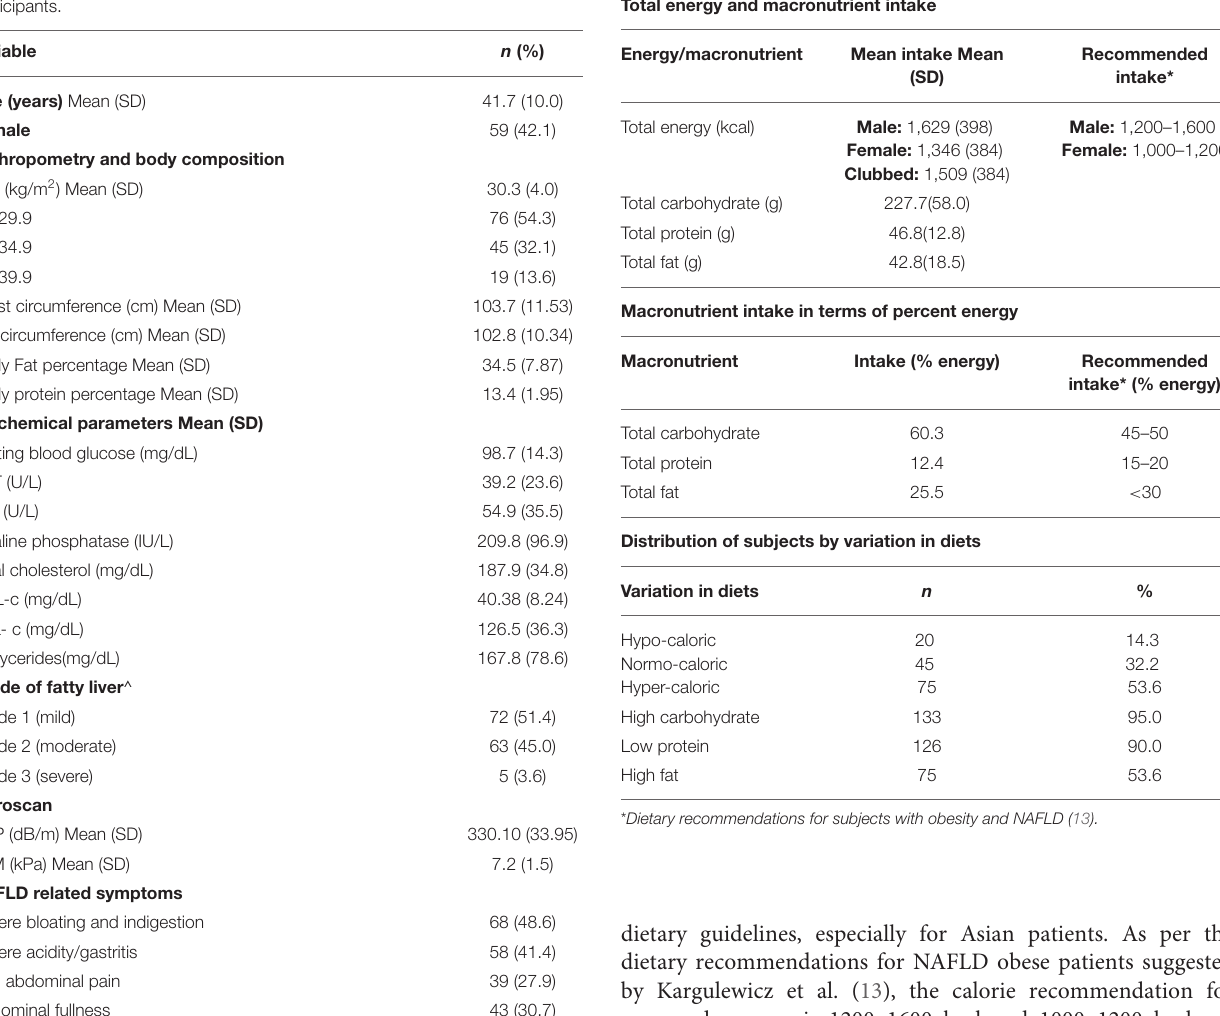
TABLE 1 | Demographic, anthropometric, biochemical, radiological characteristics, NAFLD related symptoms and physical activity level of the study participants.